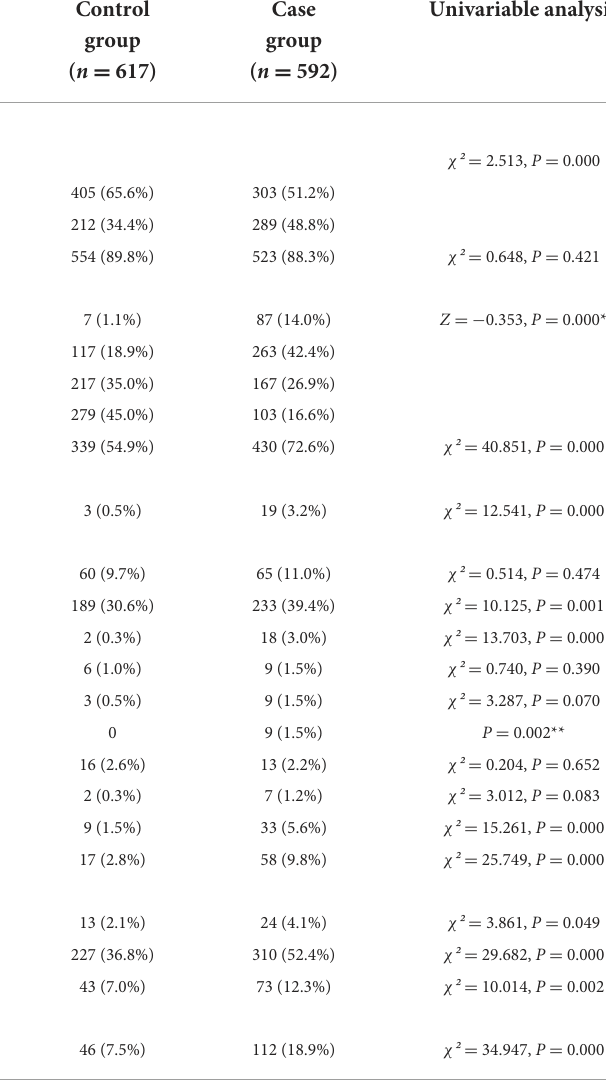
TABLE 1 Comparison of baseline characteristics in case and control groups.